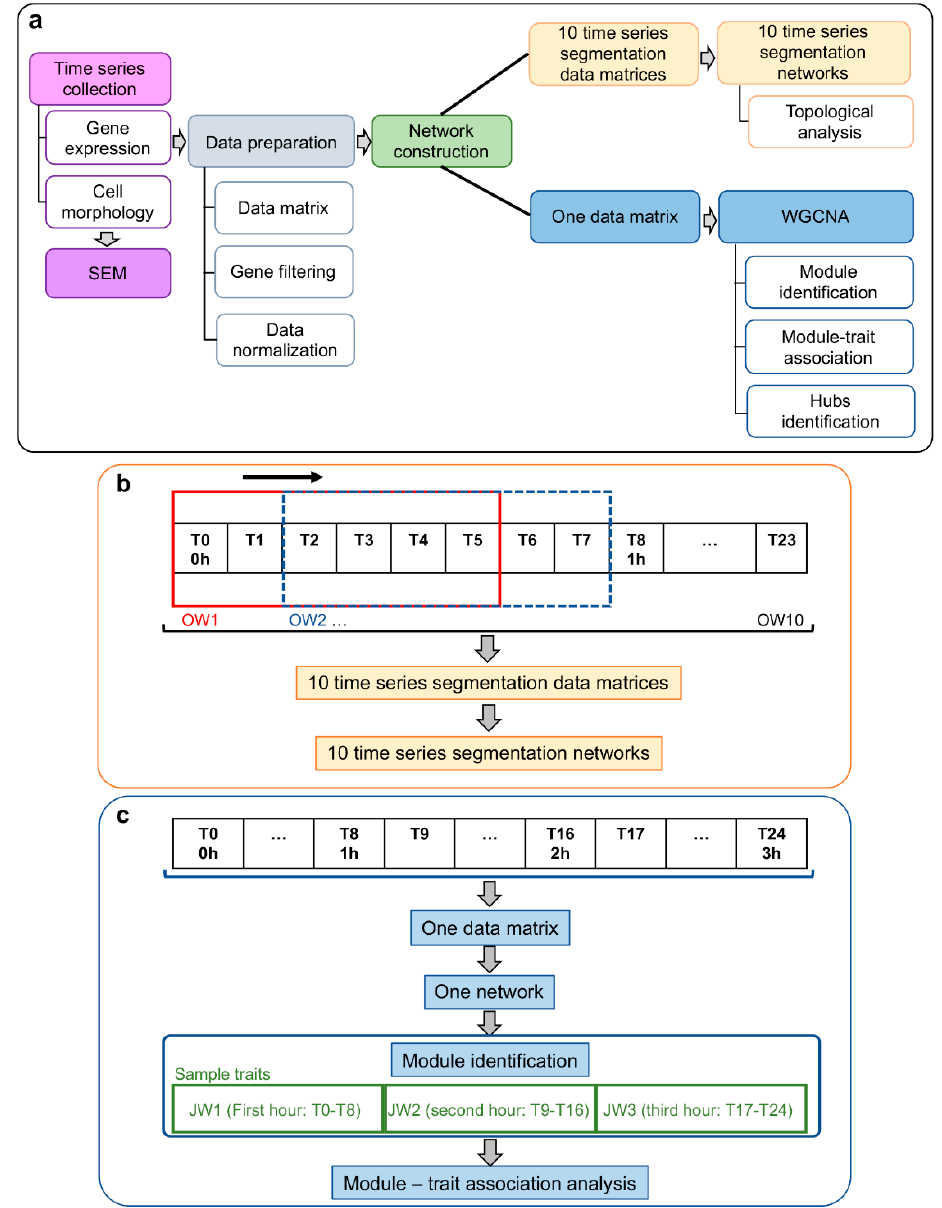
Figure 1. Workflow of time series collection and analysis for investigating Caco-2 cells-STEC interactions. ( a ) Time series data analysis and the 3D network and WGCNA approaches for network construction. ( b ) Sliding-window analysis for investigating temporal dynamic network variations along three hours of enterocyte–bacteria interaction. Each overlap window (OW) represents a fifteen minutes interval and each window included data from six sequential time intervals, i.e., the red box indicates the first window (OW1) and the dashed blue box indicates the second window (OW2). ( c ) Gene network construction by WGCNA for investigating module–trait associations. STEC, Shiga toxin (Stx)-producing Escherichia coli ; WGCNA, Weighted Gene Co-Expression Network Analysis; JW, juxtaposed windows.